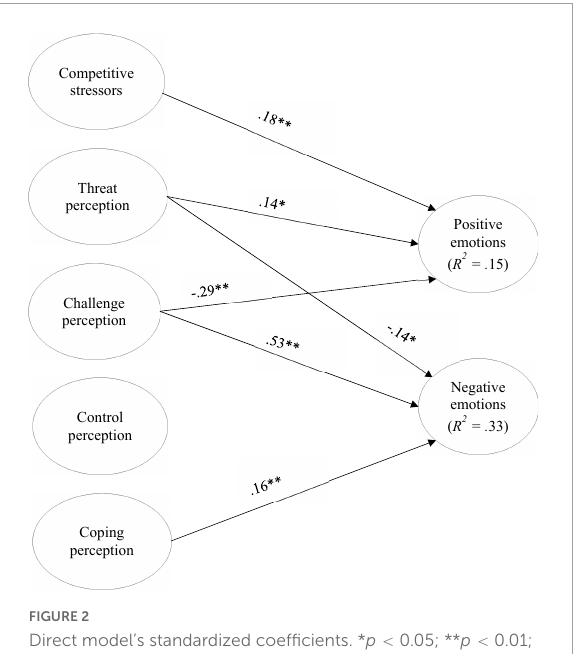
FIGURE2 Direct model’s standardized coefficients. * p < 0.05; ** p < 0.01; only significant paths are displayed.